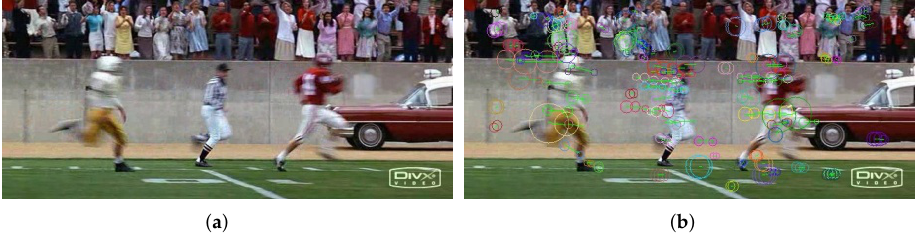
Figure 1. Illustration of MoSURF tracking. It shows the No.230 frame captured from the video ‘actionclipautoautotrain00385.avi’ in the Hollywood2 dataset. ( a ) The initial picture including human movement. ( b ) MoSURF tracking on different